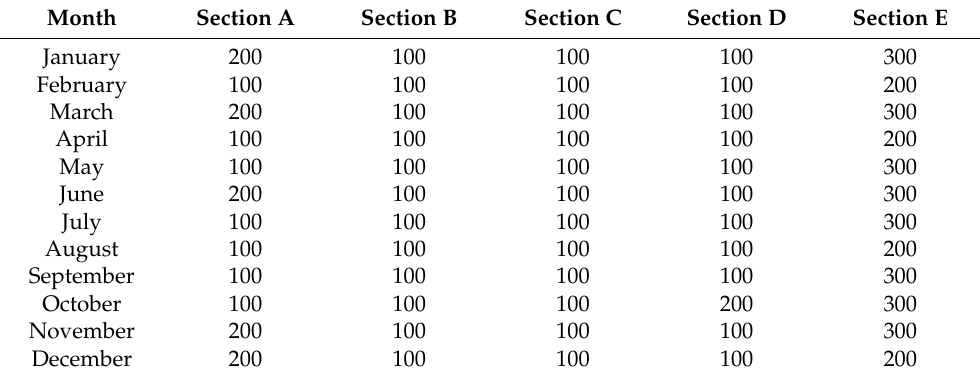
Table 3. Transmission section quotas during maintenance in twelve months (MW).